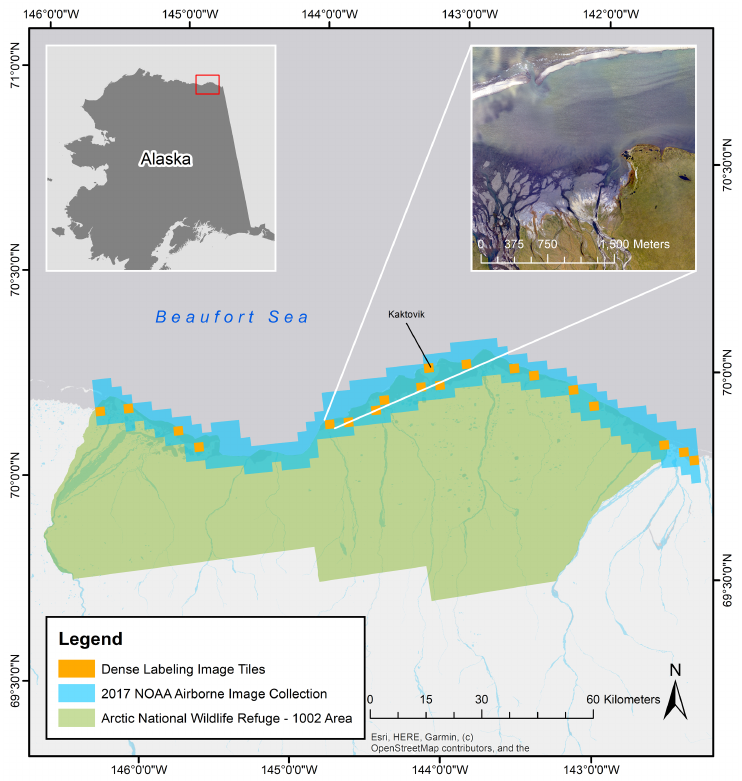
Figure 2. Overview map showing the ANWR region on the eastern North Slope of Alaska, the extent of the 2017 NOAA airborne image collections (in blue) and the individual image tiles (in orange) from this collection used for creation of dense testing labels. The top right corner displays an example high resolution airborne image of a section of coastline acquired by the NOAA RSD airborne